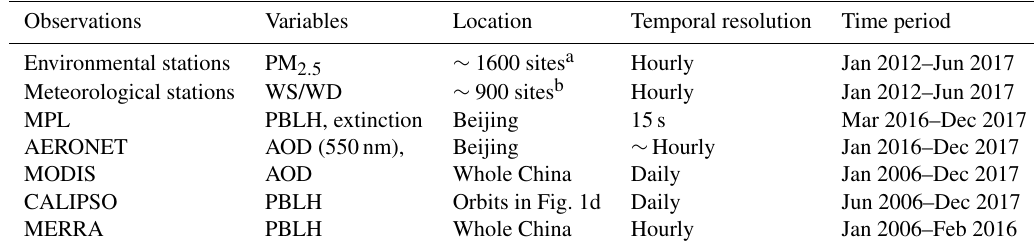
Table 1. Description of data. Observations Variables